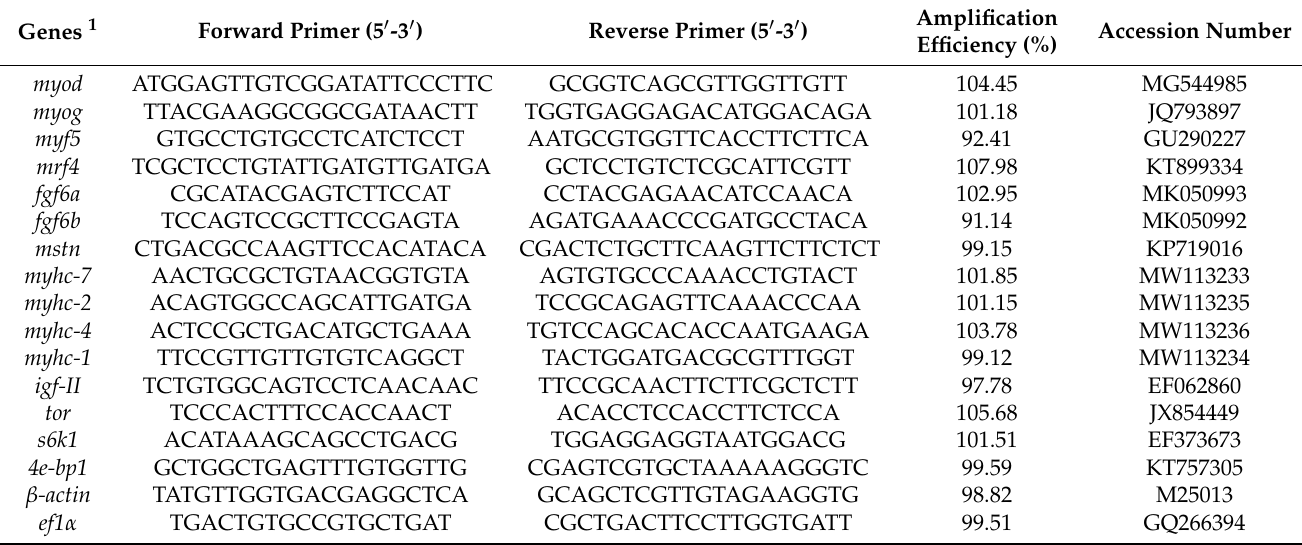
Table 2. Real-time PCR primer